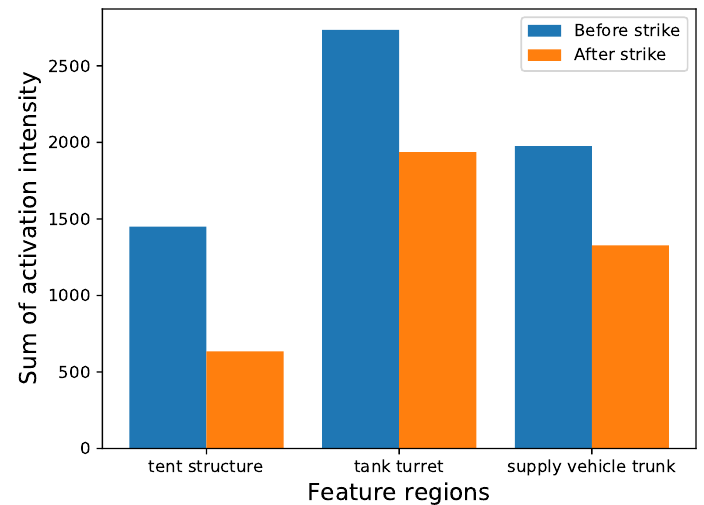
Figure 15. The changes in the activation intensity of the clustered convolution